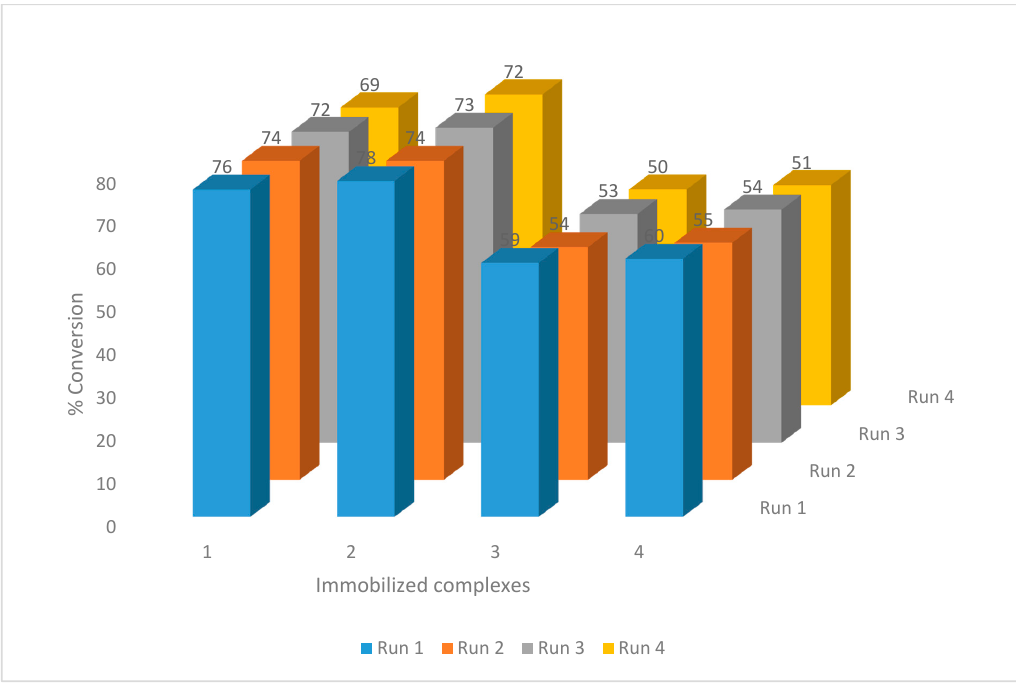
Figure 4. A graph showing the catalytic activities of complexes 1 – 4 and their recycling. Reaction conditions were time, 24 h; P CO : 60 bar; temperature, 90 ° C; solvent, methanol/toluene (100 mL) complex 1 – 4 ; Pd:PPh 3 :PTSA:1-hexene ratio of 1:2:10:200; and 1-hexene (2 ml, 16.00 mmol).